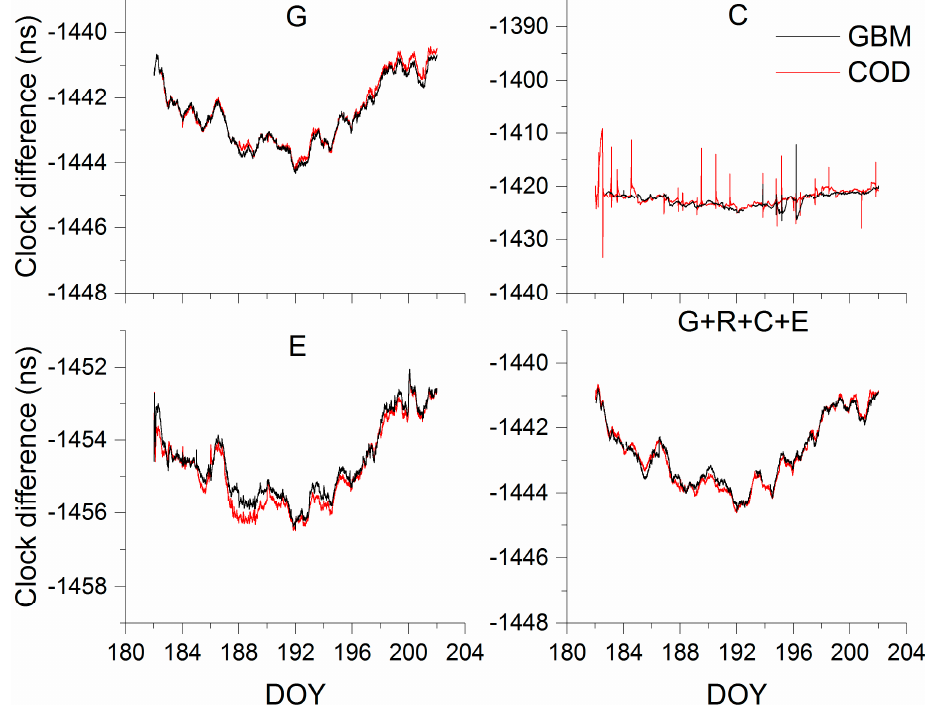
Figure 4. The clock difference in single-system and multi-GNSS models on BRUX and NTSC using GBM and COD products.